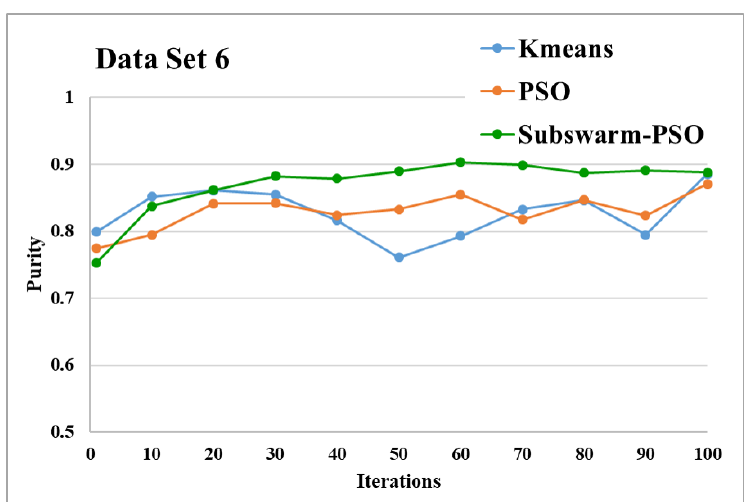
Figure 15. Purity comparison for data set